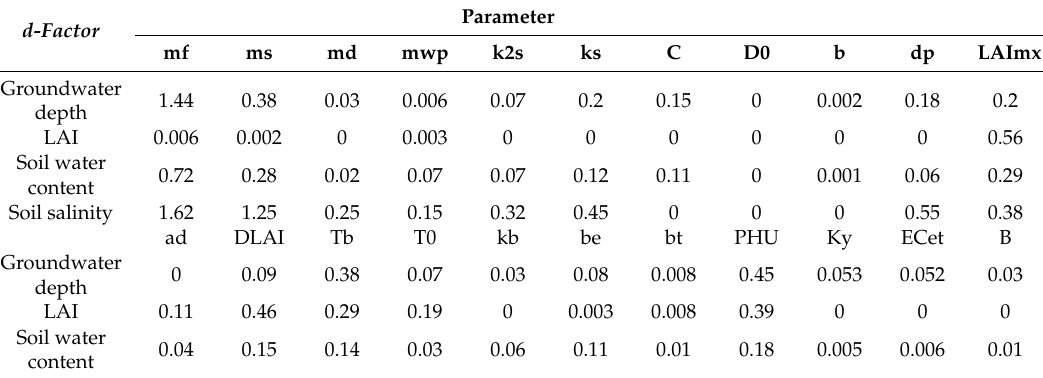
Table 6. Uncertainty analysis of parameters for modified